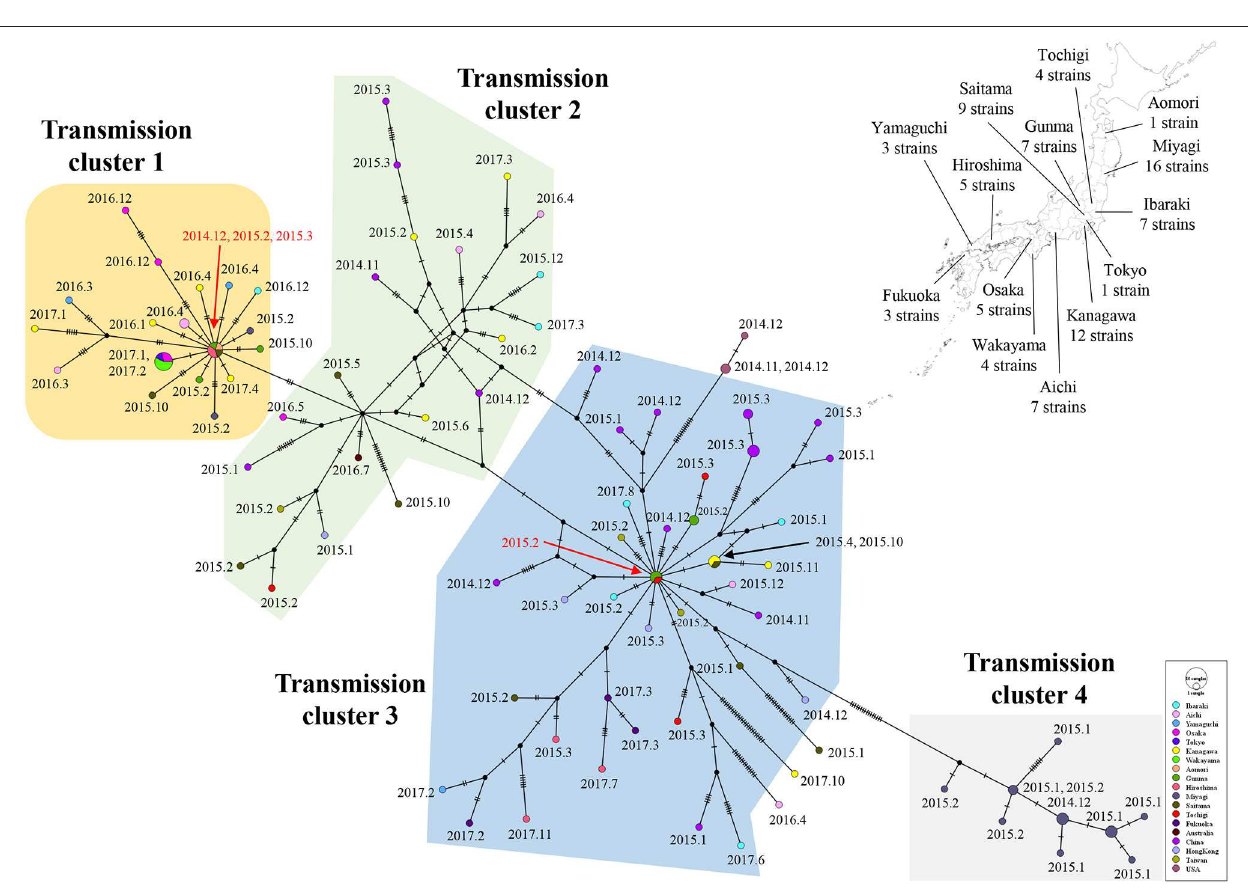
FIGURE 7 | A median joining network for the major epidemic cluster of GII.P17-GII.17 strains based on nucleotide sequences from the RdRp to VP1 (3133 bp). The detected areas for Japanese strains used in the analysis are shown with the number of strains on a Japanese map. The filled circles represent viral haplotypes, including collection years and months for the strains. The sizes of the circles represent the number of strains within the haplotype. Red arrows indicate strains associated with the production of many